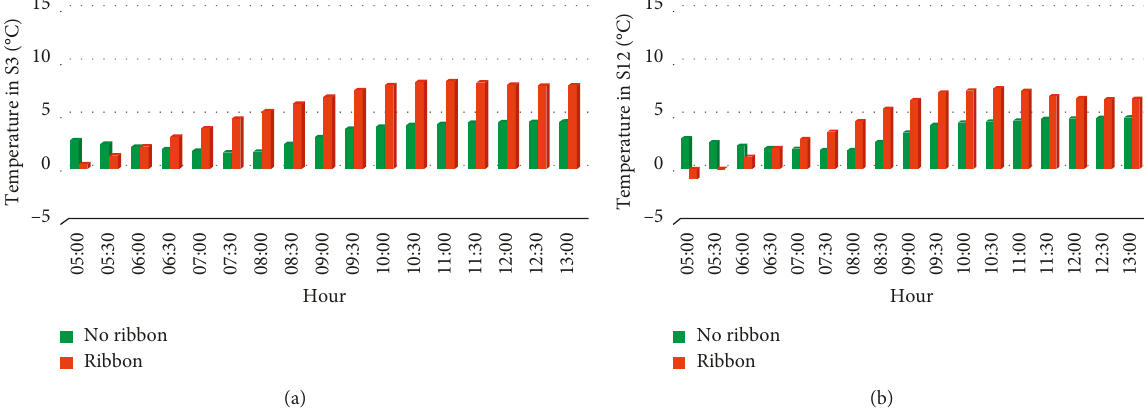
No ribbon Ribbon